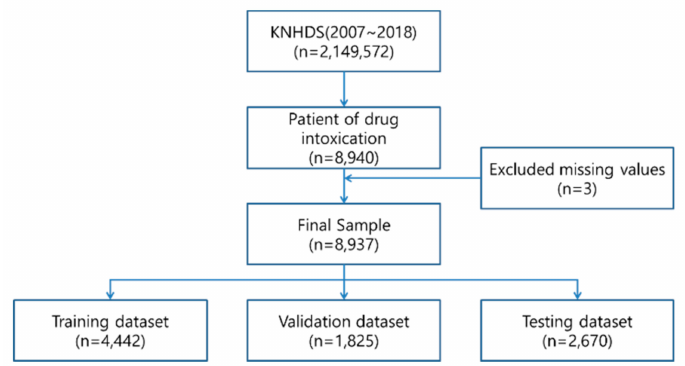
Figure 1. Sample